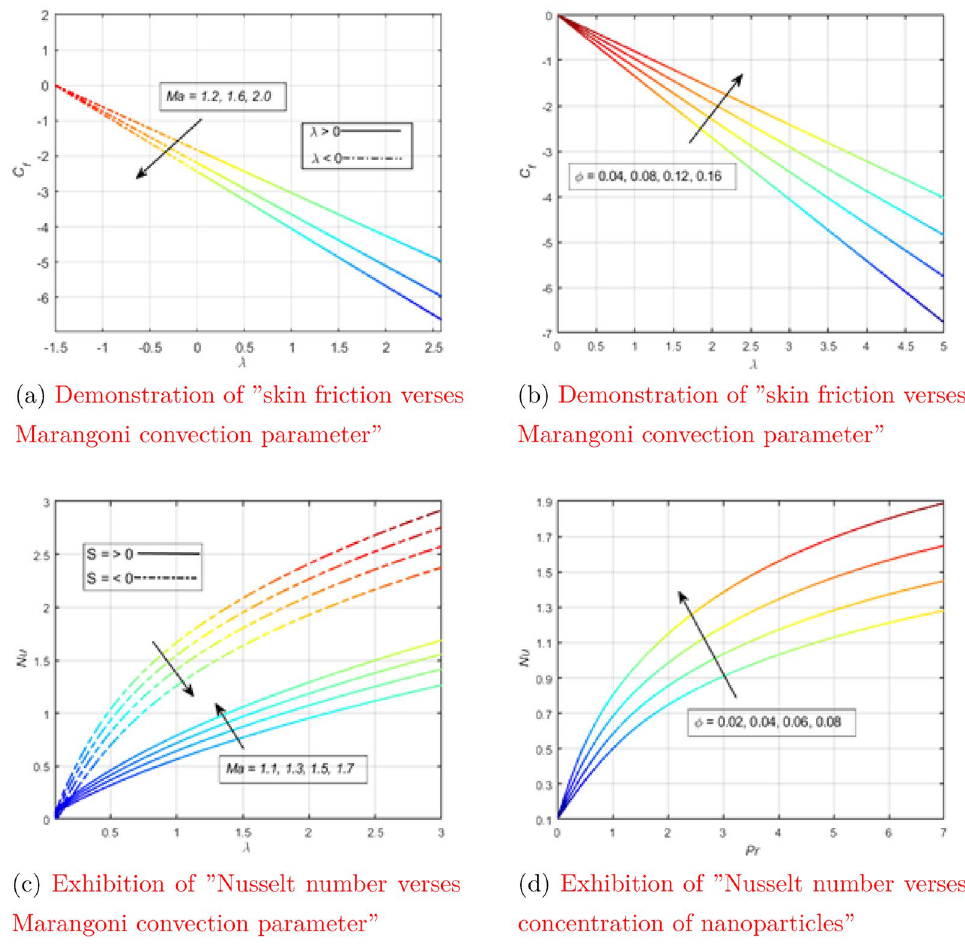
Figure 6. Exhibition of the influence of physical parameters on physical quantities (see Appendix